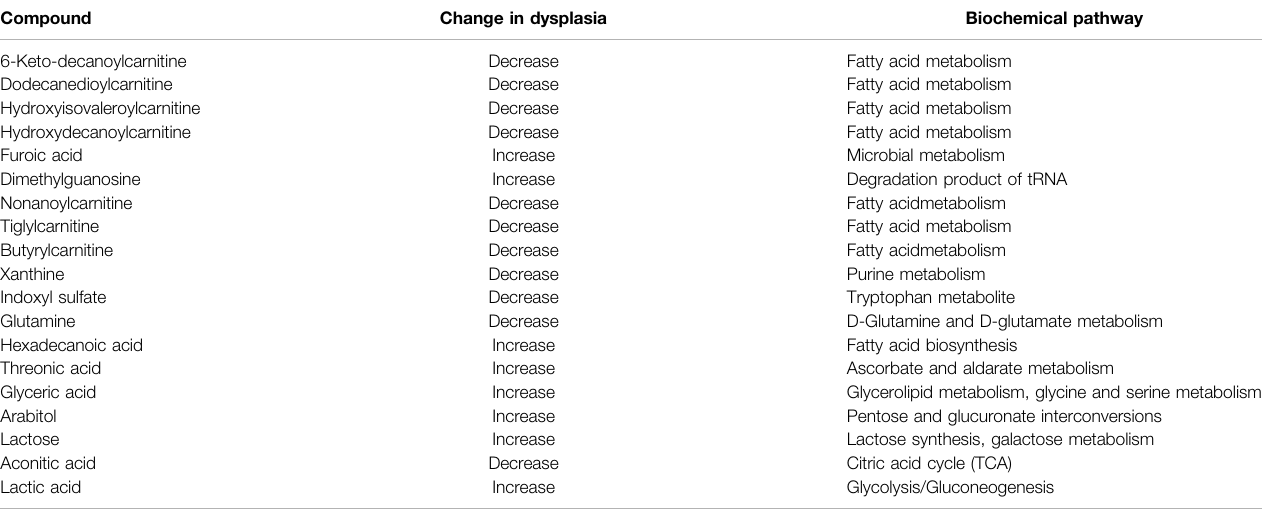
TABLE 5 | Metabolic signature of renal dysplasia, unrelated to eGFR value. Compound